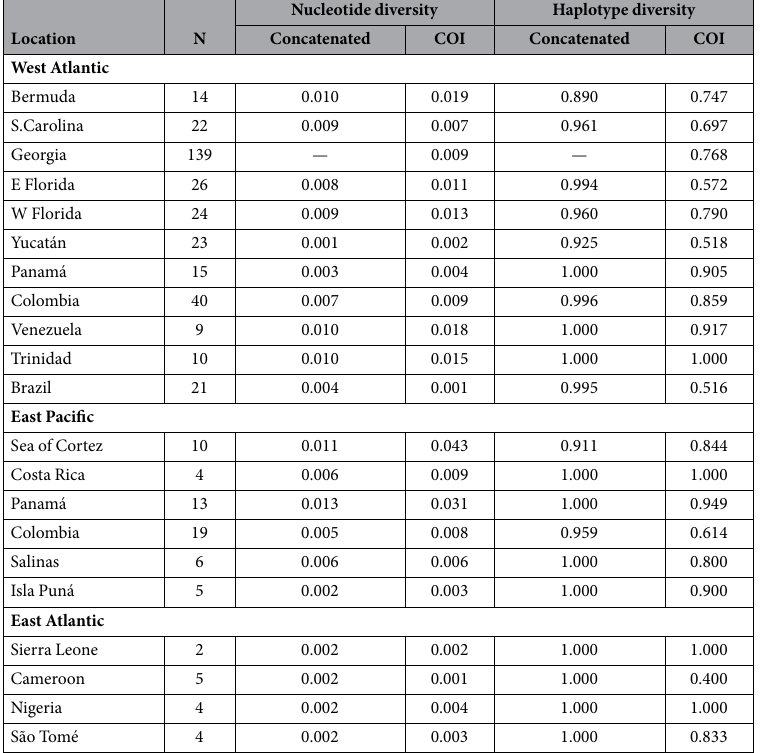
of individuals. These estimates of IMa2 are for the separation of the mixture of haplotypes transported into these localities relative to haplotypes in the rest of the species range. That populations at Georgia and South Carolina were the result of massive transfer, rather than having been started from a few individuals was also supported by their high genetic variability (Table 3). Both nucleotide and haplotype diversity in these populations were amongst the highest of all sampled populations with N > 10. Thus, the IMa2 results from the invaded localities reflect past history of the mixture of invaders. Estimates from the rest of the populations, however, are more likely to reflect population history. According to IMa2 estimates, the population of Petrolisthes armatus in Bermuda, the geographically most isolated locality in the western Atlantic, has been separated from all other localities 1.6 × 10 5 to 2.1 × 10 6 years ago (Table 2) and has received little gene flow since then, except from Trinidad and the coast of Colombia (Table 4). The four haplotypes of the SW Atlantic clade found in South Carolina (Figs 1 and 3) were interpreted by coales- cence as having arrived from Bermuda, as well as Venezuela and Yucatán (Table 4). To the extent that the analysis of the shorter COI-HL fragment can be trusted, there has also been some gene flow from the founder haplotypes of Georgia into Bermuda (Table 4). The separation of the population in eastern and western Florida from pop- ulations that belong to the southern Caribbean clade has also been > 10 5 years ago (Table 2). The split between populations on the two coasts of Florida was estimated as much more recent. Gene flow between the two Florida populations has been relatively high, whereas gene flow into southern populations was not significantly different from 0 (Table 3). However, there has been asymmetrical gene flow from the Caribbean coast of Colombia, as also seen in the phylogenetic analysis (Figs 1 and 3). All estimated times of separation of populations within the SW Atlantic clade were in the order of 10 5 years, except for those involving Brazil; the latter were more than a million years old with the exception of more recent isolation from Yucatán and Venezuela (Table 2). Most migration rates between Brazil and populations of the SW Atlantic clade were also not significantly different from 0 (Table 3). The contiguous Atlantic coasts of Panamá and Colombia registered both by F ST values (Table 2) and by IMa2 estimates (Table 3) as containing a single, panmictic population. Populations at Yucatán and the Caribbean coast of Colombia appeared as exchanging a high number of propagules. Interestingly, the two NW Atlantic clade haplotypes found in Colombia (Figs 1 and 3) did not contribute to migration rates significantly different from 0 in IMa2. In the eastern Pacific, estimated times of isolation between the population in the Sea of Cortez and any other population (including the one in Panamá) was > 1.5 × 10 6 years (Table 2). Despite their geographic proximity, but in agreement with their distant phylogenetic affinity, populations on the coast of Panamá and of Colombia were also estimated to have been initially separated > 2 × 10 6 years ago, longer than the isolation between populations at Panamá and the two localities at the coast of Ecuador (Salinas and Isla Puná). The most recent separation is